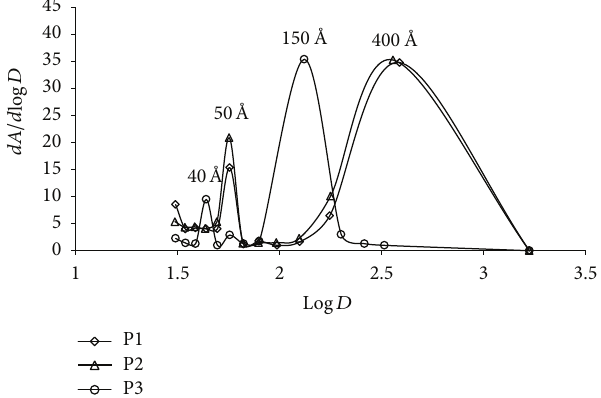
Figure 6: Pore size distribution of calcined Malaysian dolomites: 𝐷 : pore diameter (˚A), 𝐴 : BET surface area (m 2